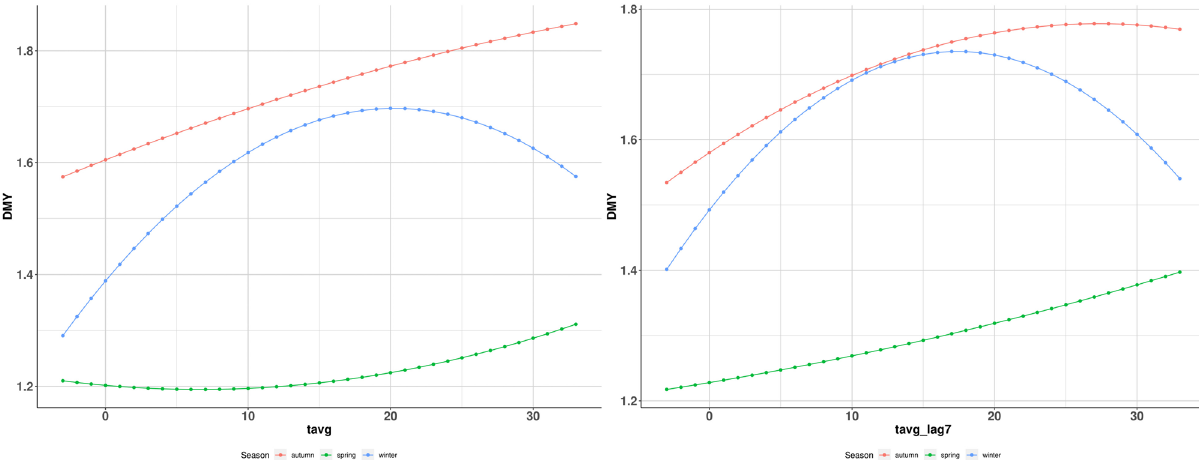
Figure 1. Derived average reaction norm by lambing season from the Eq. (2) corresponding to population level response. Each curve represents changes in daily milk yield (DMY, kg) in response to average air temperature variation on the milk test date (tavg, °C) and cumulatively during the week preceding the milk test date (tavg_ lag7, °C), respectively. Red line: autumn lambing, blue line: winter lambing, green line: spring